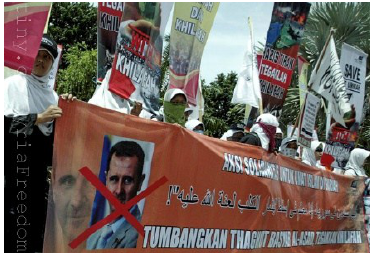
Figure 6. Indonesian members of the Hizbut Tahrir Indonesia (HTI) attend a protest against Syria’s President Bashar al-Assad in Surabaya on 3 March 2012, courtesy Freedom House.